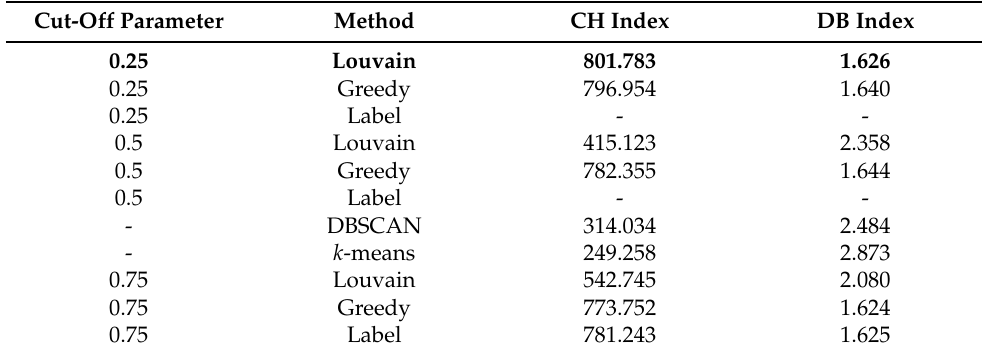
Table 4. The Calinski–Harabasz (CH) and Davies–Bouldin (DB) index values for the different methods and different cut-off parameters (retail